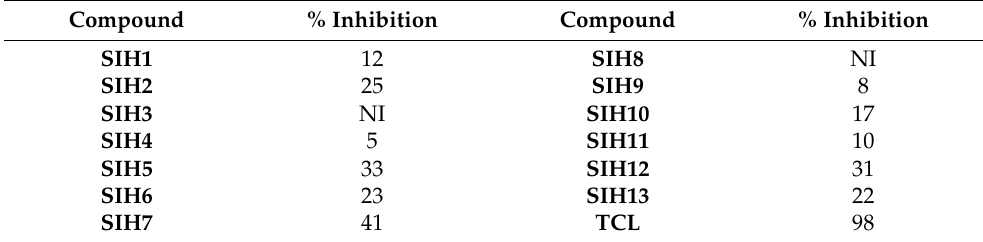
Table 2. Inhibitory results for SIH1–SIH13 against InhA enzyme at 50 µ M concentration. Compound % Inhibition